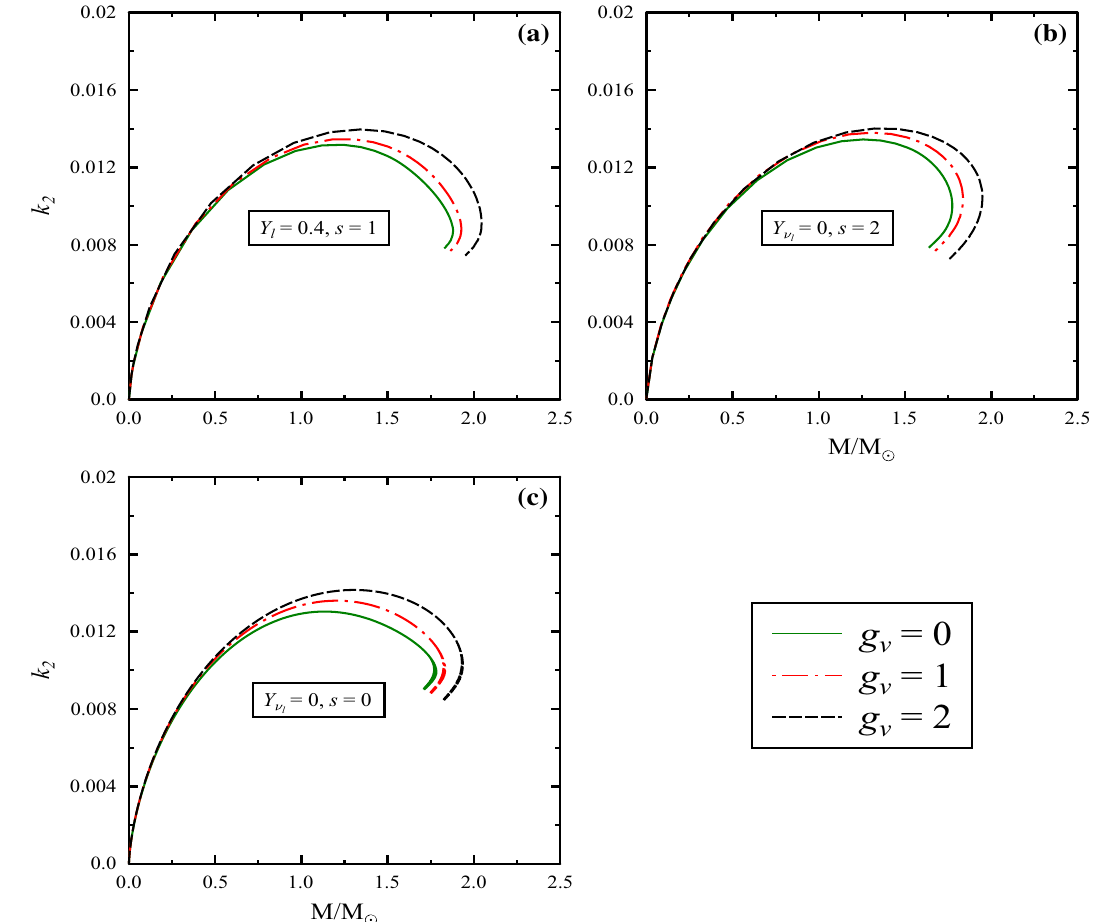
Fig. 9 Relation between Love number, k 2 and the mass of SQS for different moments of the star evolution at g v = 0, 1 and 2